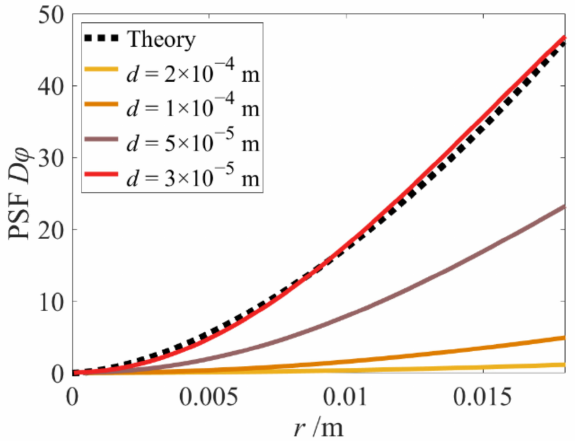
Figure 4. The average PSF of the simulation model with different sampling